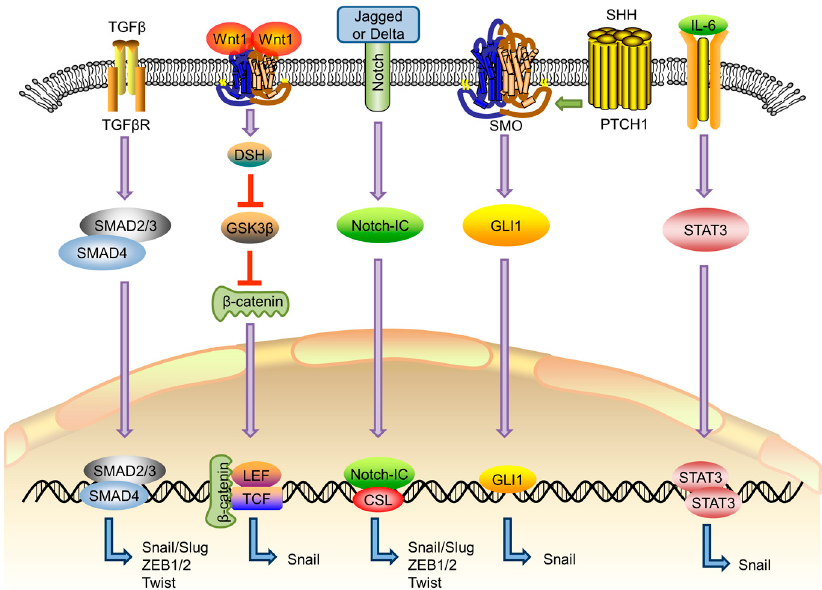
Figure 1. Diverse signaling pathways associated with epithelial–mesenchymal transition